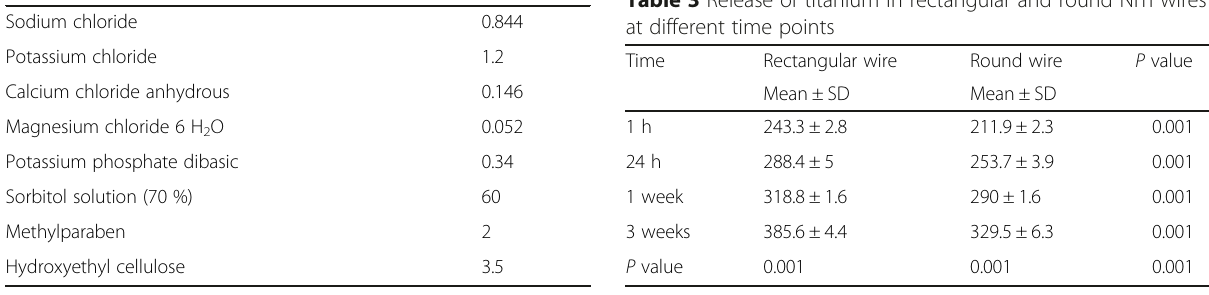
Table 3 Release of titanium in rectangular and round NiTi